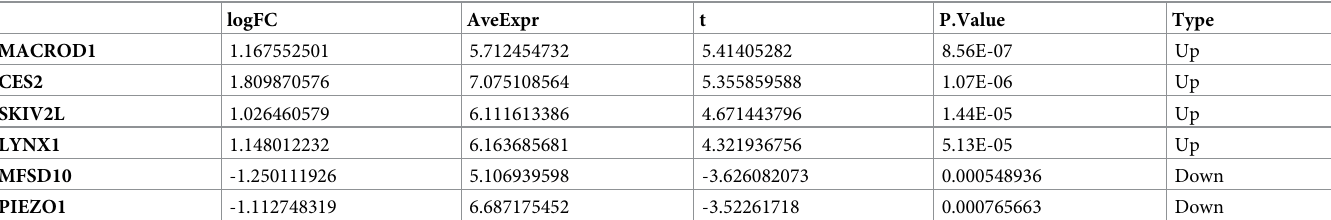
Table 1. 6 potential hub gene